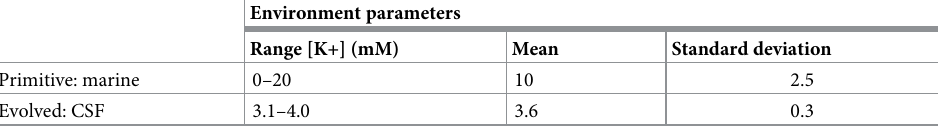
Table 3. Parameters of marine and CSF environment to be used in the distribution